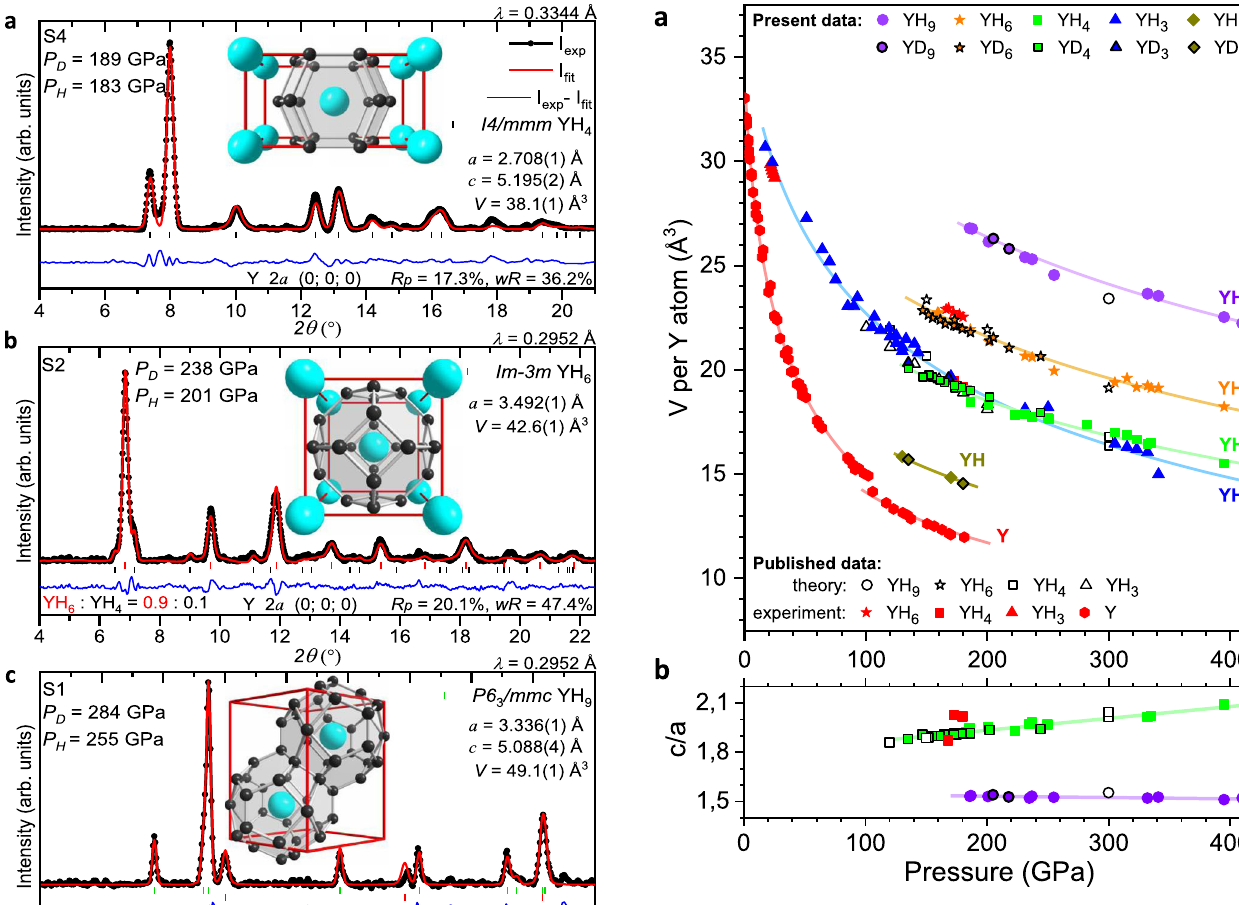
Fig. 2 Volume of various synthesised yttrium hydrides as a function of pressure. a The experimental data for the P6 3 /mmc YH 9 , Im-3m YH 6 , I4/mmm YH Fm-3m YH Fm-3m YH phases are shown as fi lled violet 4 , 3 and circles, orange stars, green squares, blue triangles and dark yellow rhombuses, respectively. The data for the corresponding yttrium deuterides Fig. 1 X-ray powder diffraction patterns of the synthesised yttrium are outlined in black. Open black circles, stars, squares and triangles hydrides. a I4/mmm YH 4 phase in sample 4 (S4) after pulsed laser heating correspond to the theoretically predicted structures for YH 9 22 , YH 6 22 – 24,26 , at P H = 183 GPa; b Im-3m YH 6 phase in unheated sample 2 (S2) at YH 4 22 – 24,26 and YH 3 31,32 , respectively. Experimental data for pure Y 33,63 , P = 201 GPa with a T ∼ 211 K; c P6 /mmc YH H c of 3 9 phase in sample 1 (S1) YH 3 59 , YH 4 26 and YH 6 26 taken from the literature are depicted by the red after pulsed laser heating at P H = 255 GPa with a T c = 235 K. See symbols. Solid curves correspond to the Vinet 30 equation of state fi tting. Supplementary Table 1 for details. P H and P D correspond to the pressures The pressure was estimated from the frequency of the H 2 (D 2 ) vibron 54 for estimated by H 2 (D 2 ) vibron scale 54 and diamond scale 55 , respectively. The the samples with excess H 2 (D 2 ) and from the high-frequency edge of the black circles and red and blue curves correspond to the experimental data, Raman line from the stressed diamond anvil 55 for the remainder of our Rietveld re fi nement fi ts and residues, respectively. The black, red and green samples. b The pressure dependence for the lattice parameter ratio c / a in ticks indicate the calculated peak positions for the I4/mmm YH 4 , Im-3m the P6 3 /mmc and I4/mmm phases with linear fi YH 6 and P6 3 /mmc YH 9 phases, respectively. The weight fractions for the phases, re fi ned lattice parameters and coordinates for Y atoms are shown for each re fi nement. The fragments of the crystal structure with the characteristic YH 18 , YH 24 and YH 29 coordination polyhedra (cages) are shown as insets. The large cyan and small black spheres show the positions of the Y and H atoms in the crystallographic unit cells according to Peng et al. 22 .